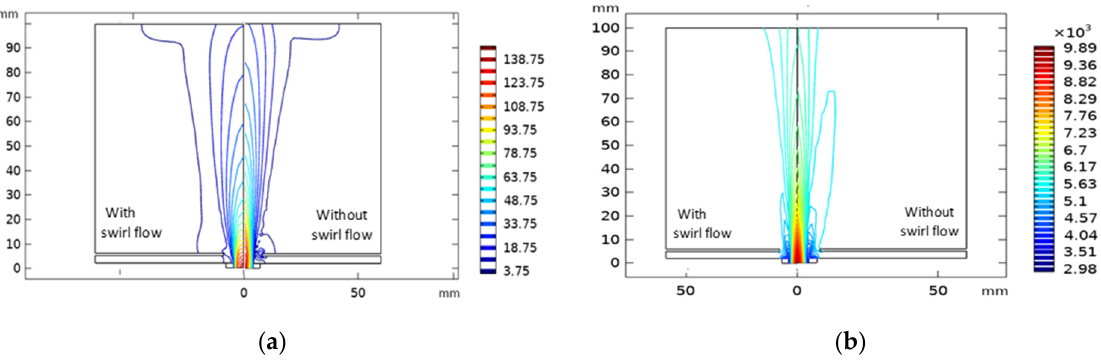
Figure 8. Swirl flow impact on: ( a ) the field velocity distribution, ( b ) the computed isotherms of the turbulent plasma jet.